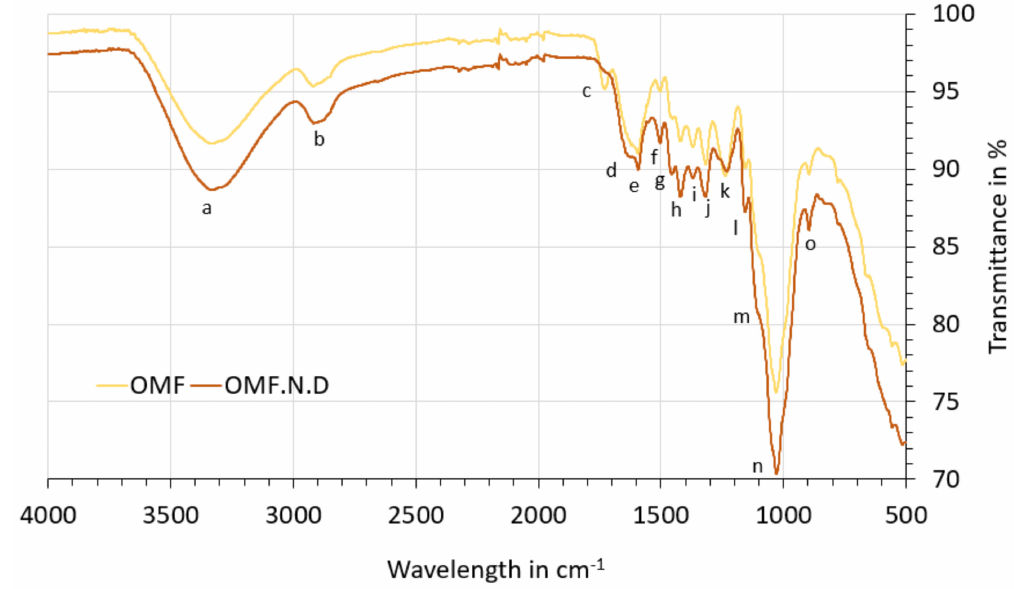
Figure 9. FTIR spectra (comparison between fibres directly collected and fibres extracted in